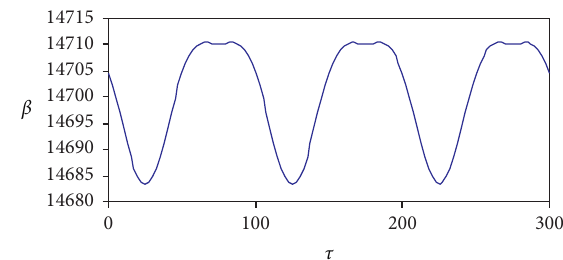
Figure 26: The analytical solution β for case (iii) in Section